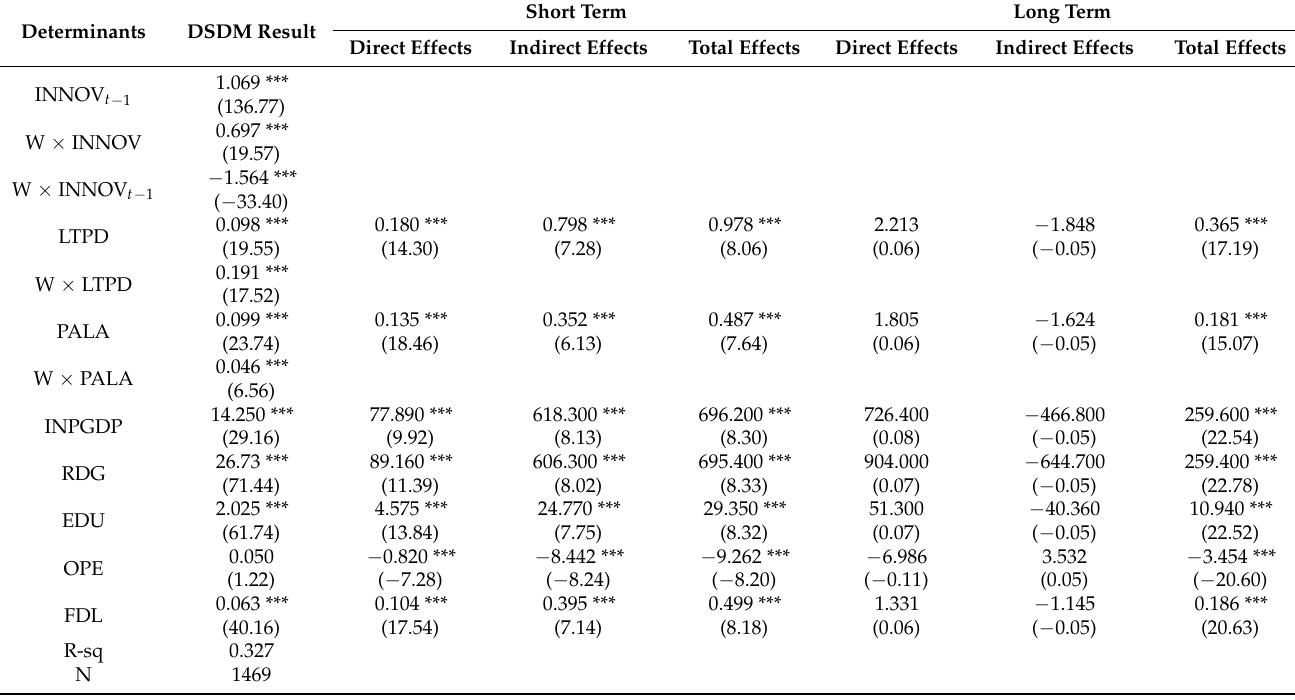
Table 6. Results of regression and effects decomposition for East China.